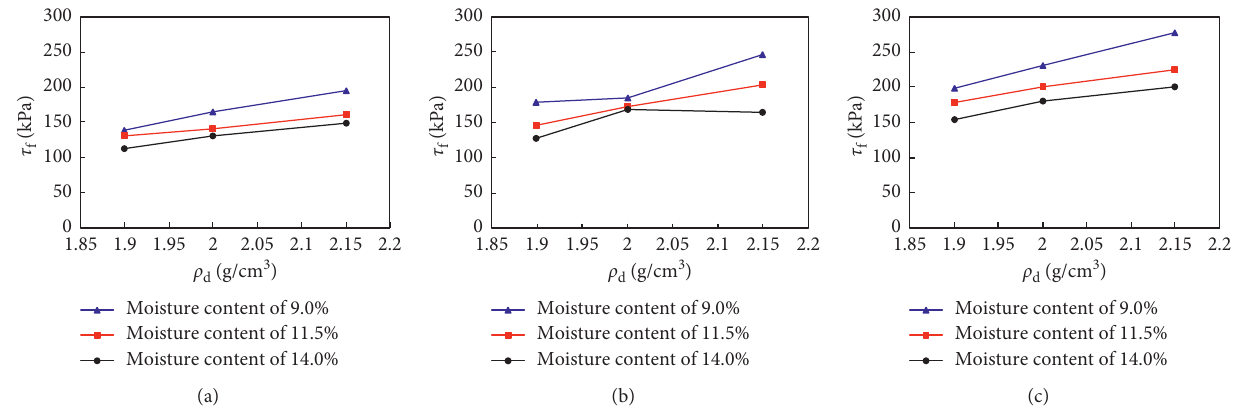
Figure 7: Relationship between shear strength ( τ